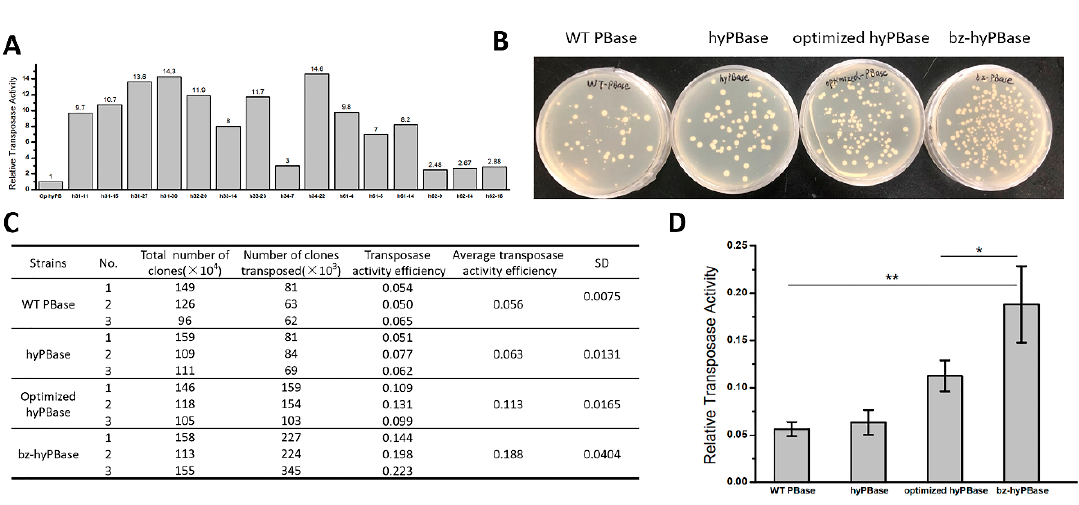
Figure 3. Isolation of piggyBac transposase mutants in S. cerevisiae. ( A ) Relative activities of 15 hyperactive mutants in yeast. The transposition efficiency of optimized hyPBase was set as 1.0, and the increase folds of hyperactive mutants were marked at the top of the column. ( B ) The transposition assay of wild-type (WT) PBase, hyPBase containing seven amino acid mutations, the codon-optimized hyPBase, and bz-hyPBase. bz-hyPBase, which we isolated with four mutation sites, exhibited significantly higher transposition efficiency than others. ( C ) The transposition efficiency of WT PBase, hyPBase, optimized hyPBase, and bz-hyPBase. The transposition efficiency = number of clones reversed growth on -ura medium plate / total number of clones × 100%. ( D ) Relative activities of WT PBase, hyPBase, optimized hyPBase, and bz-hyPBase. *, p < 0.05 and **, p < 0.01.